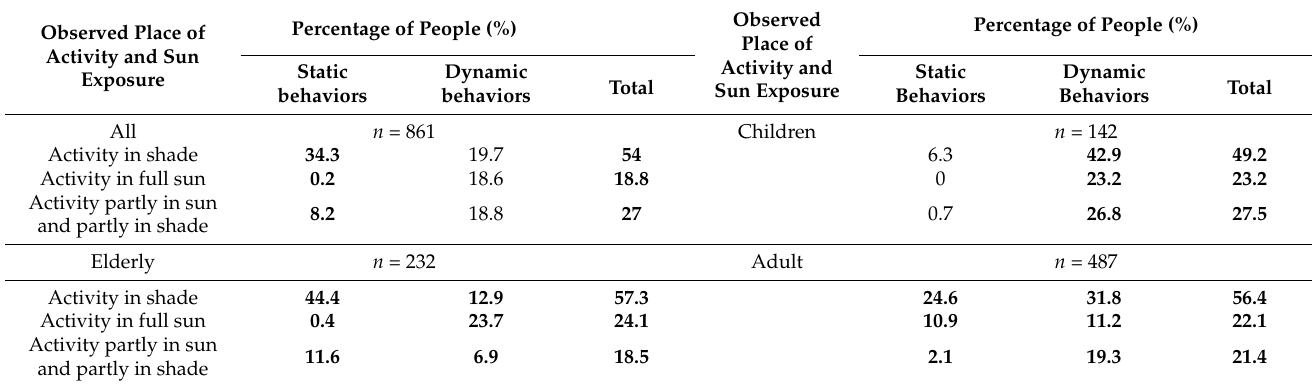
Table 4. Percentages for places of activity of observed park visitor age groups.